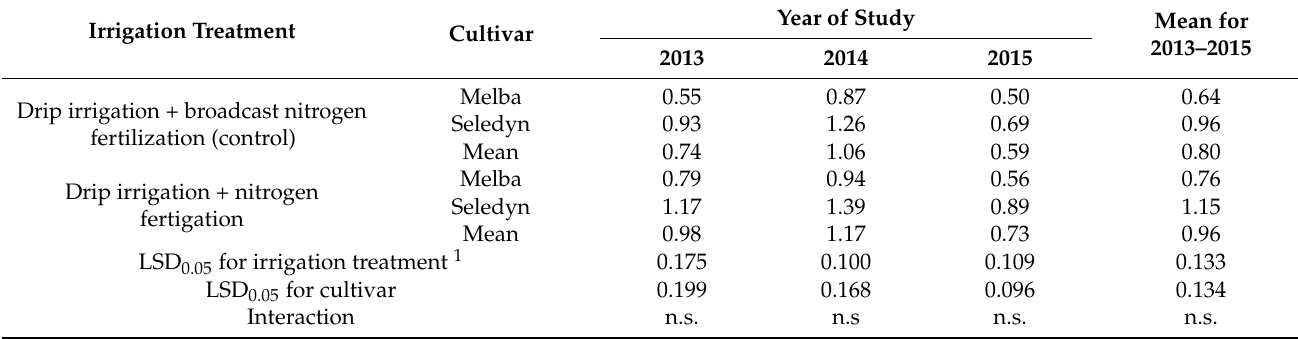
Table 4. Influence of drip fertigation on the single fruit weight (kg) of Melba and Seledyn melon cultivars in the years 2013–2015.